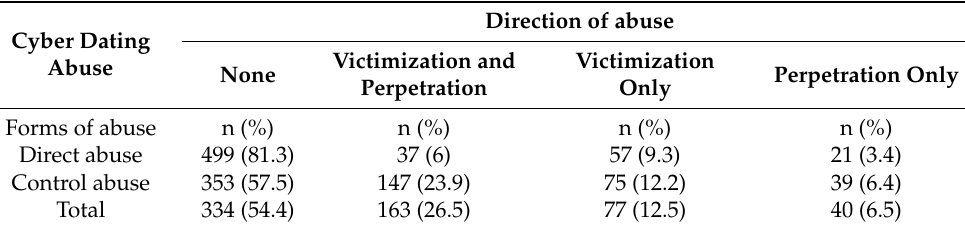
Table 2. Prevalence rates of cyber dating abuse.